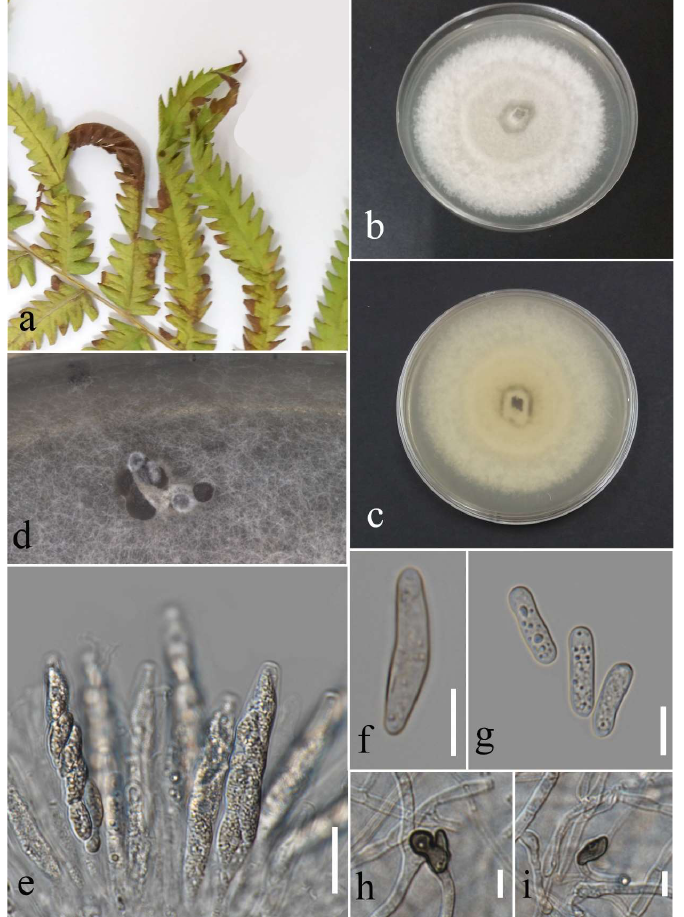
Figure 30. Morphology of Colletotrichum plurivorum based (MFLUCC 22-0167): ( a ) symptoms Cyclosorus sp . ; ( b , c ) upper and reverse views of the colony after seven days of growth on PDA at 28 °C; ( d ) ascomata on PDA; ( e ) asci; ( f ) ascospore; ( g ) conidia; ( h – i ) appressoria . Scales bars ( e ) = 20 µm ( f – i ) = 10 µm .